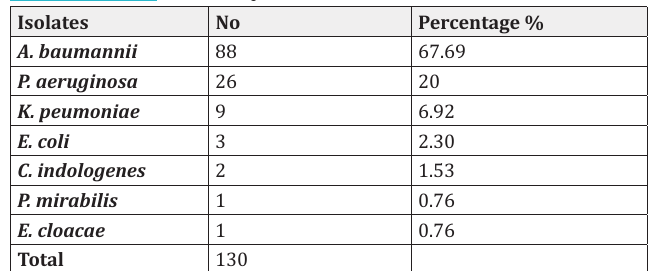
Antibiotic susceptibility test result of A. baumannii isolates